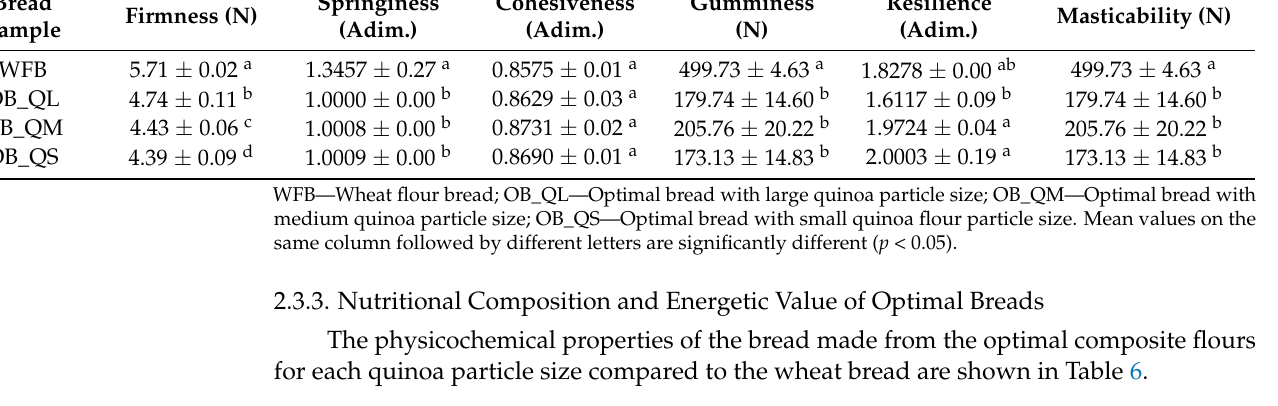
Table 6. Physico-chemical characteristics of bread with the optimal dose corresponding to large, medium, and small particle size of quinoa flour vs. wheat flour